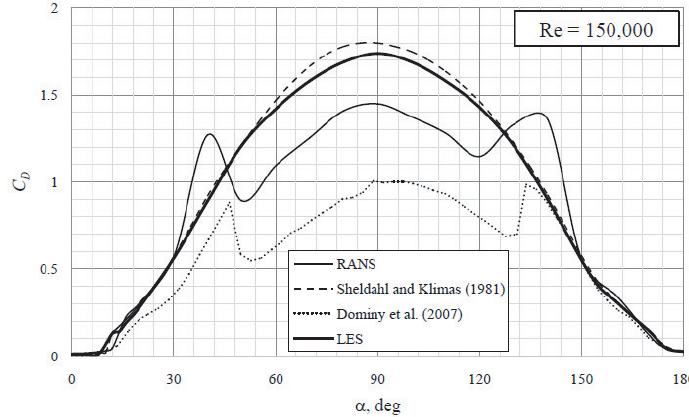
Figure 20. Drag as a function of AOA at Re = 1.5 × 10 5